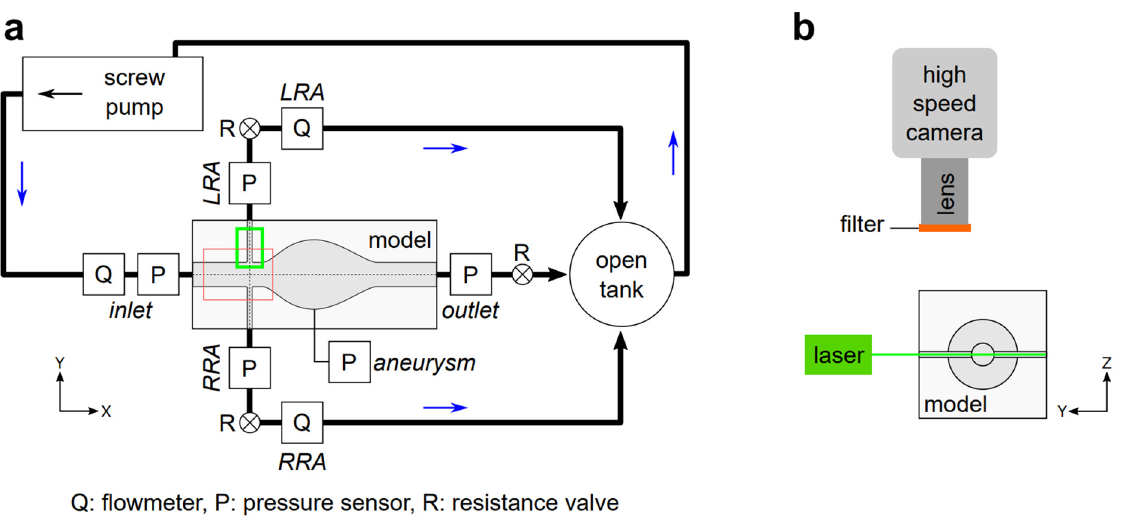
Figure 2. Experimental system. ( a ) Flow circuit with sensors. Green and red rectangles denote ROIs for PIV and uCT imaging, respectively. ( b ) Optical set-up for PIV experiments.